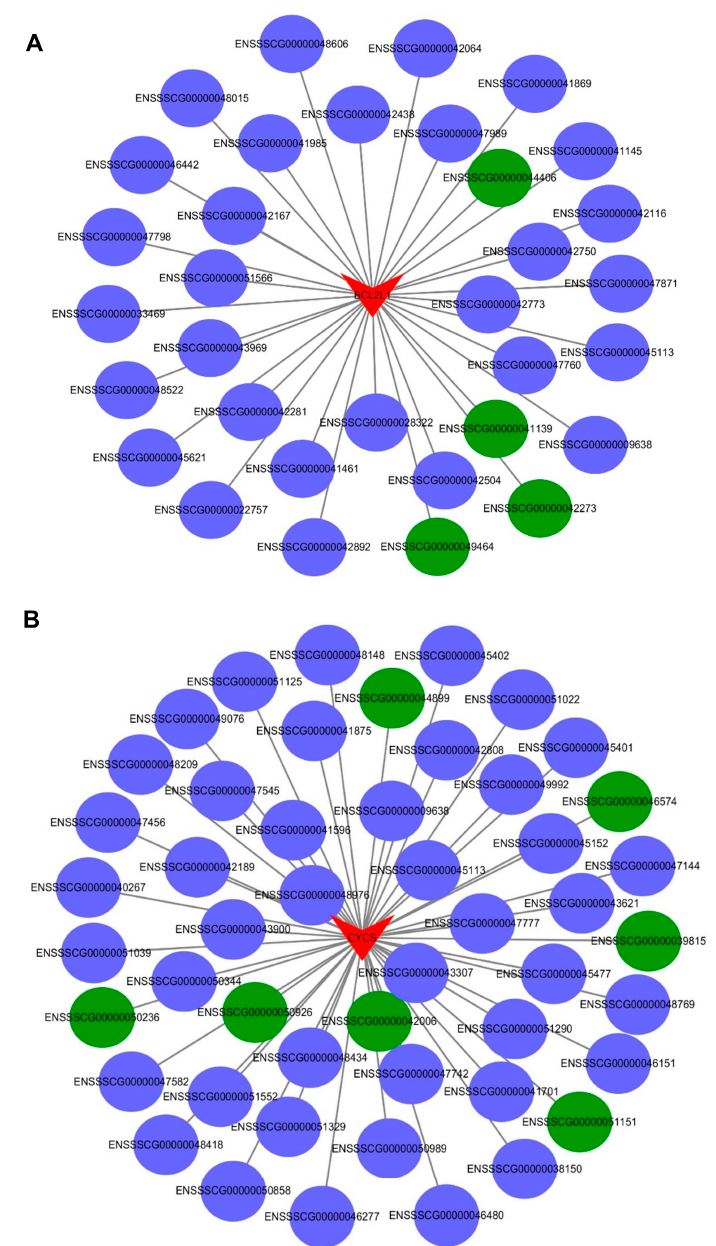
Figure 9. The interaction between the differentially expressed mRNAs and lncRNAs associated with apoptosis in the PTR2 cells infected with PRRSV. BCL2L1 ( A ) and CYCS ( B ) network analysis provide a global view of all possible lncRNA-mRNA expressions. The arrows represent mRNAs and the ellipses represent lncRNAs. Blue means up-regulation, green means down-regulation.